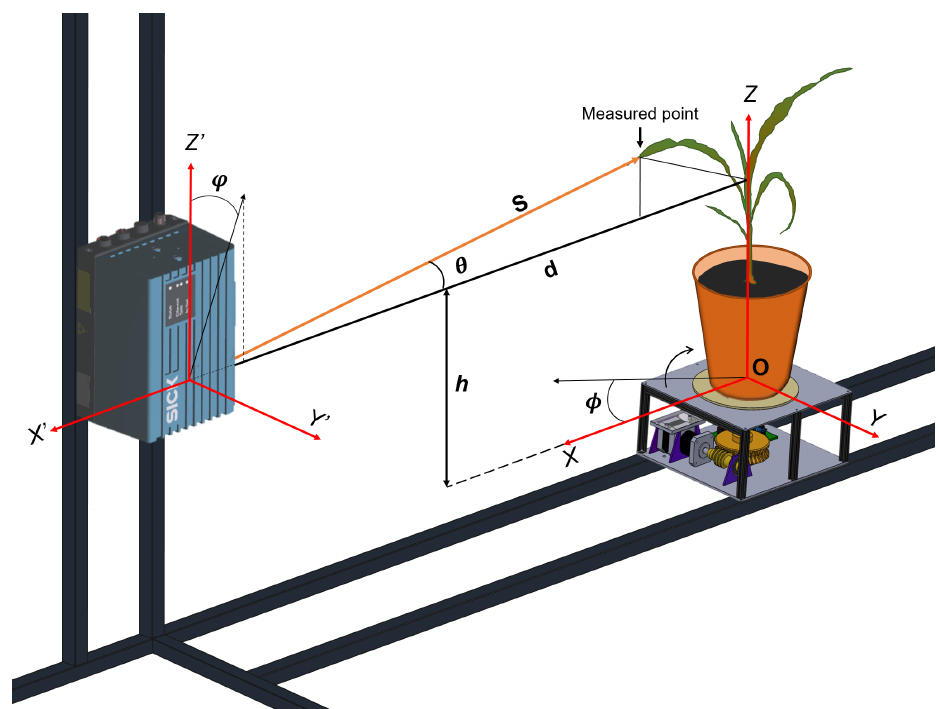
Figure 4. Schematic of the developed scanning system. The functional diagram shows the LiDAR device and the rotation platform and its reference